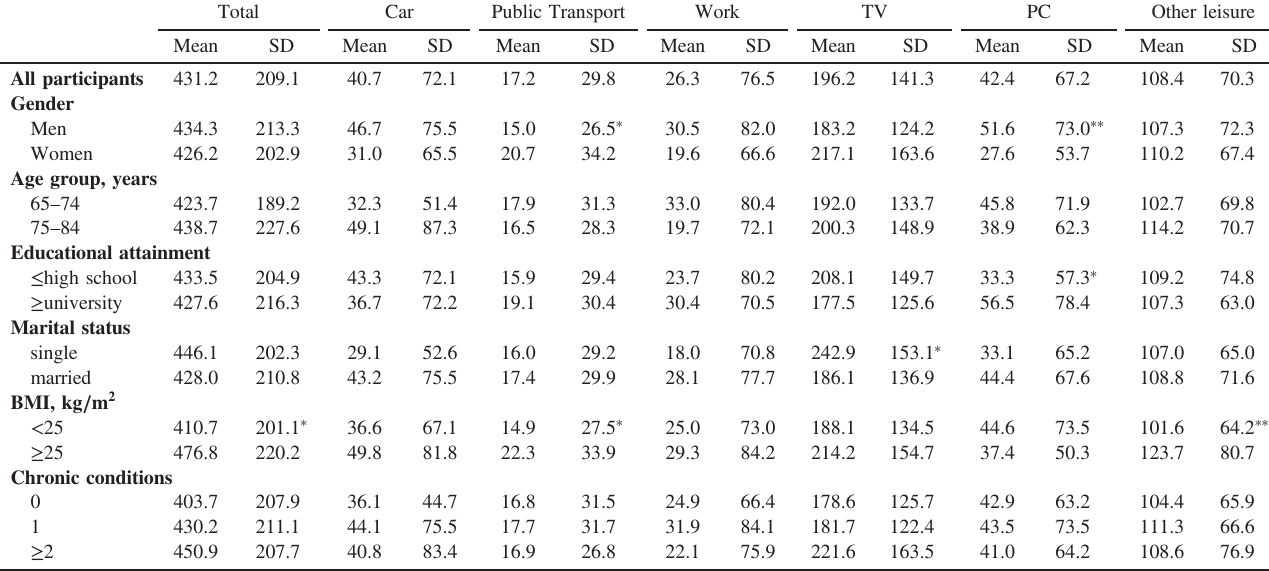
Table 2. Duration of domain-speci fi c sedentary behaviors (minutes / day) Total Car Public Transport Work TV PC Other leisure